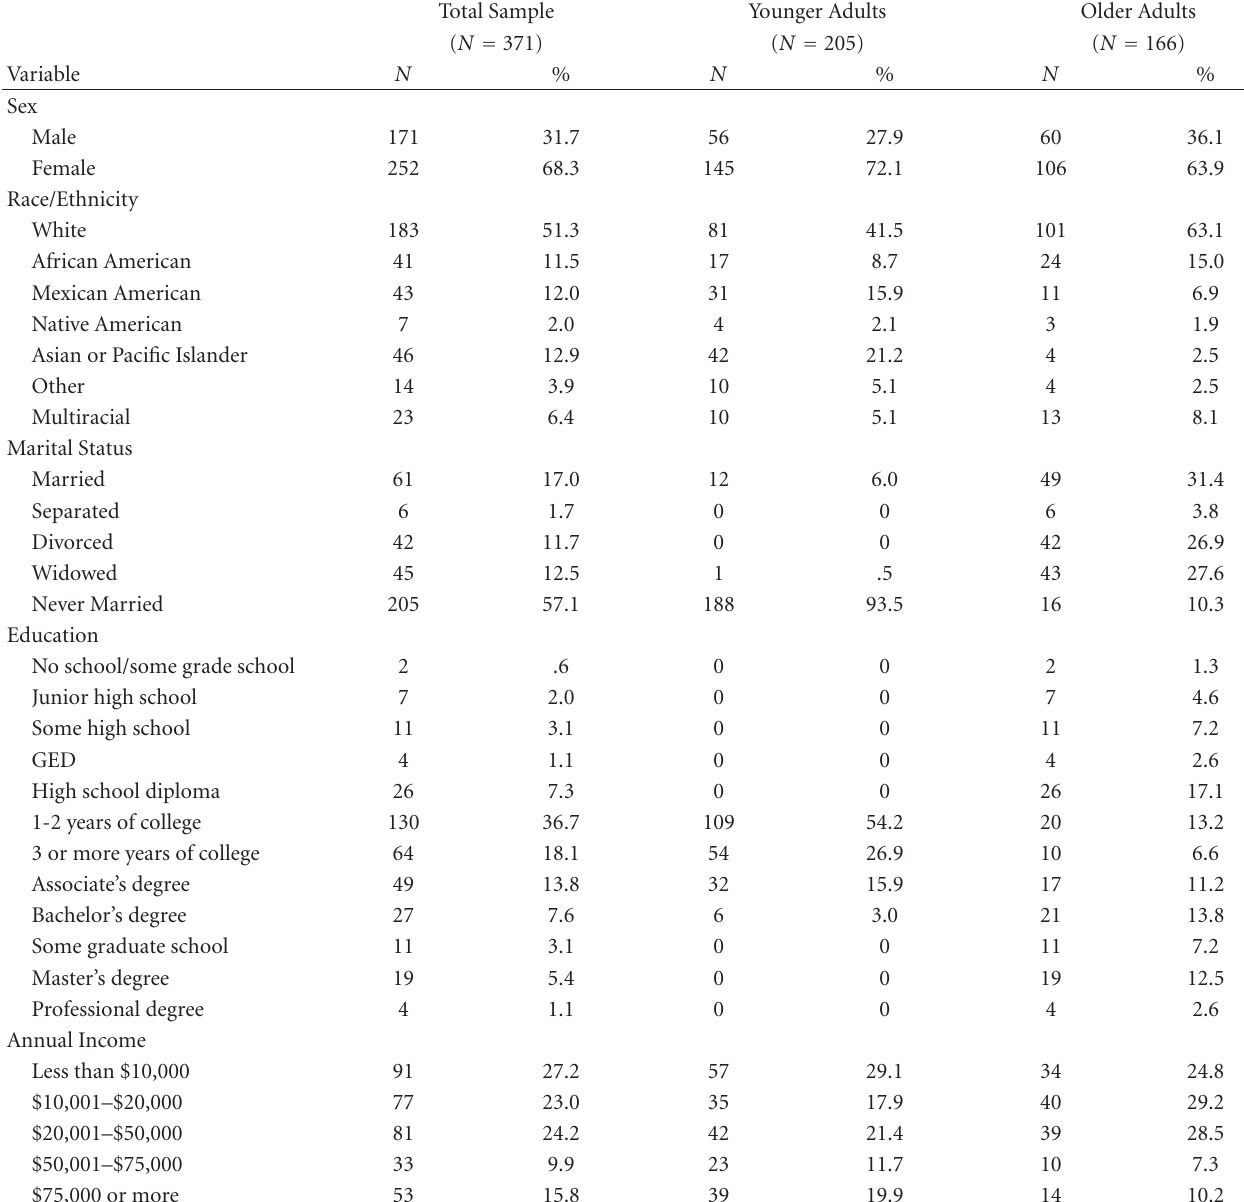
Table 1: Summary of participant